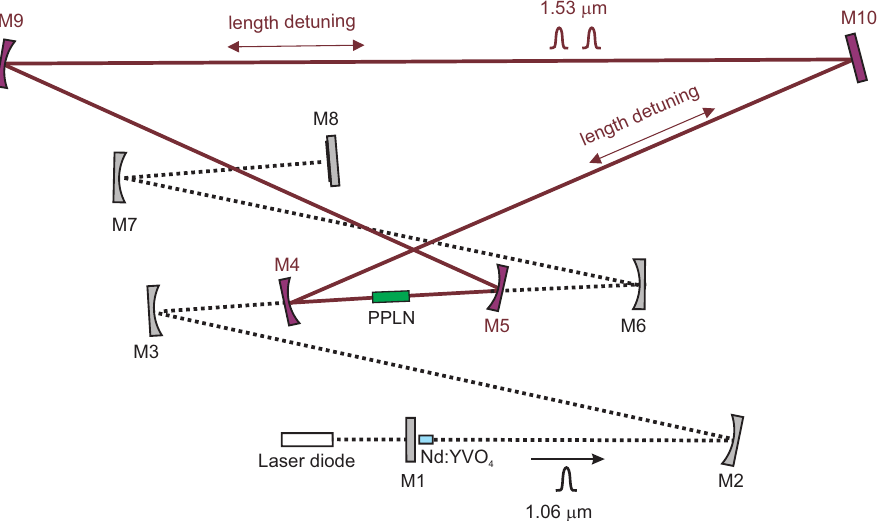
Figure 2. Diagram of diode-pumped mode-locked Nd:YVO 4 laser with an intracavity ring OPO. M1—flat mirror, M2—concave mirror ( r = 0.5m), M3, M6, M7—concave mirrors ( r = 0.3m),